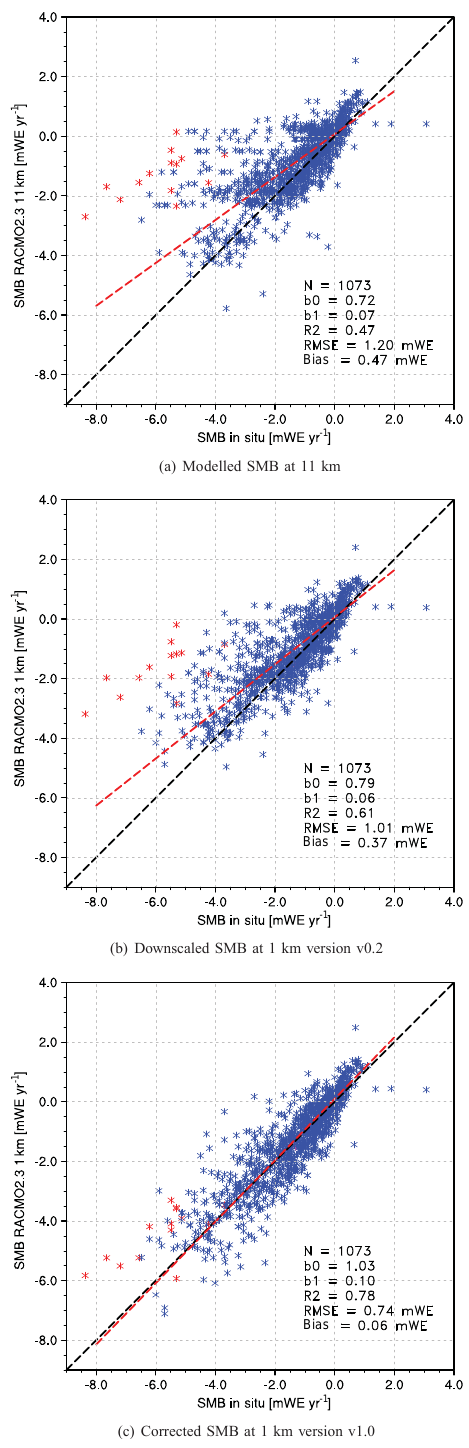
Figure 6. Comparison of SMB measurements collected at 213 sites with (a) modelled SMB from RACMO2.3 at 11km; (b) downscaled SMB at 1km (v0.2) and (c) corrected downscaled SMB at 1km (v1.0). The red stars correspond to PROMICE station QAS_L lo- cated in south Greenland (61.03 ◦ N, 46.85 ◦ W; 310ma.s.l.). The red dashed line represents the regression including all measure- ments using a perpendicular fit.